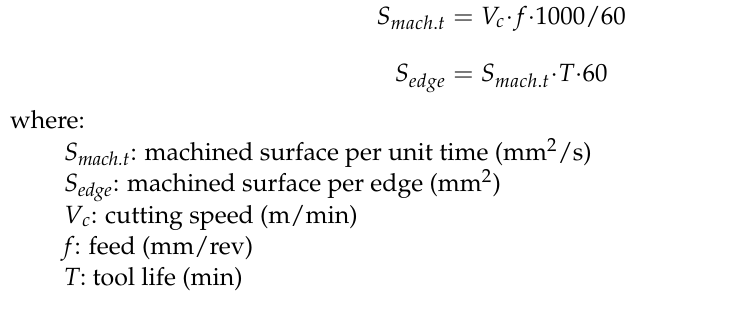
Table 4. Tool life for Haynes 282 turning tests with high pressure